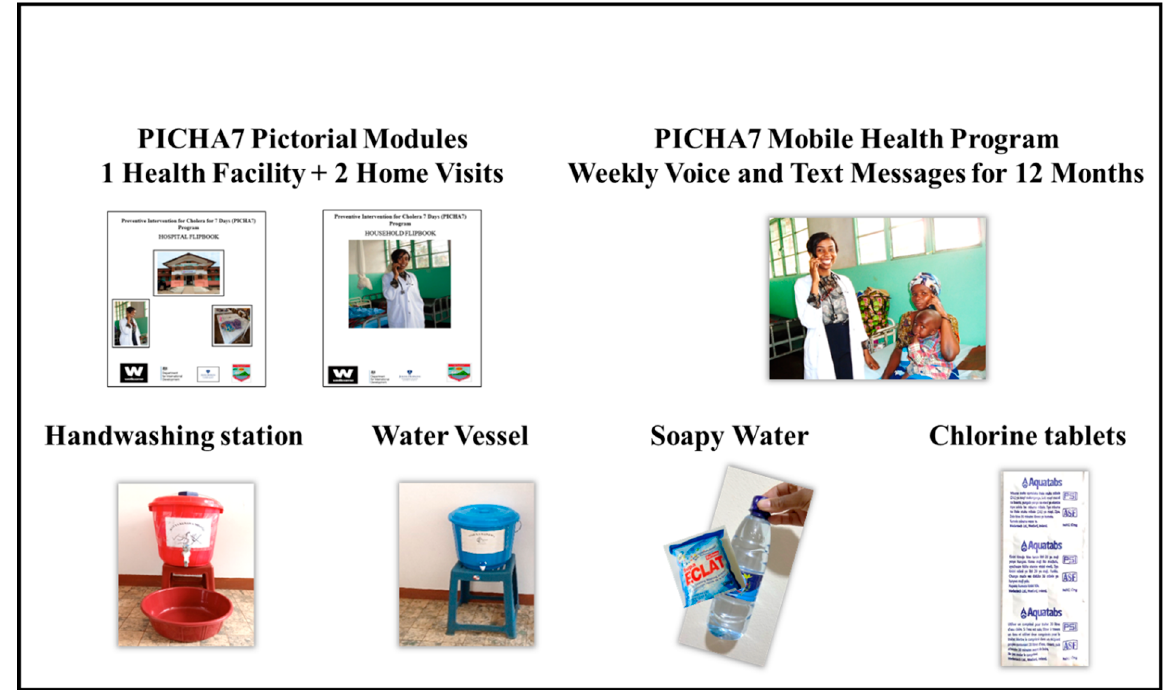
Figure 2. PICHA7 program intervention components and cholera prevention package materials.